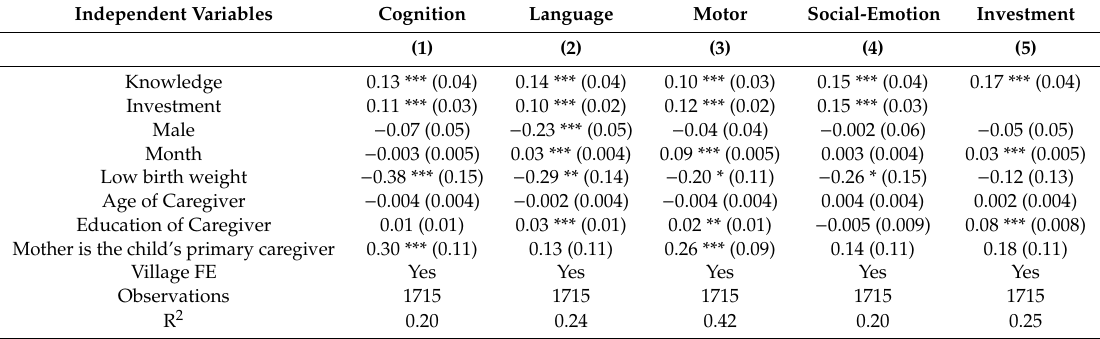
Table 2. Correlations between parenting knowledge, parental investments, and development